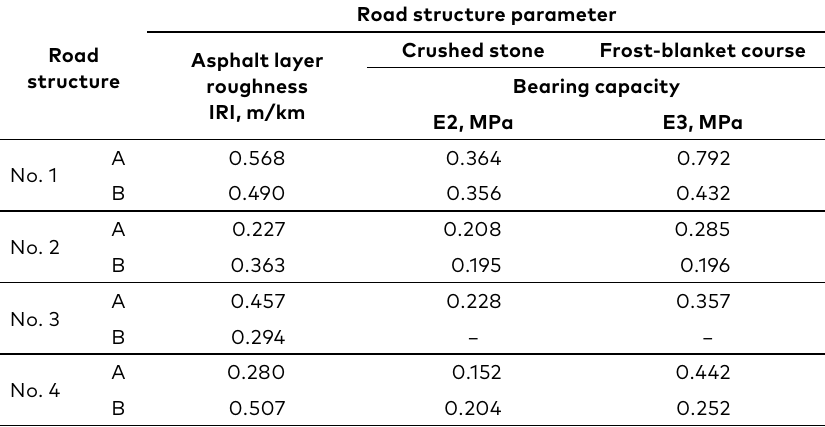
Table 5. Values of the variation coefficient in the tested road sections